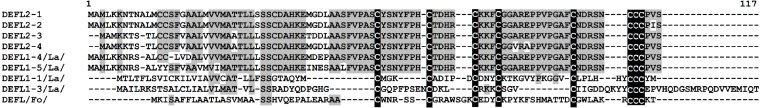
Multiple sequence alignment of T. kiharae group 2 DEFLs.DEFLs from L. arenarius (La) (Slavokhotova, Shelenkov & Odintsova, 2015) and F. oxysporum (Fo) (GeneBank EXK23984.1) were included for comparison. Cysteine residues are shaded black, identical amino acids are shaded gray.